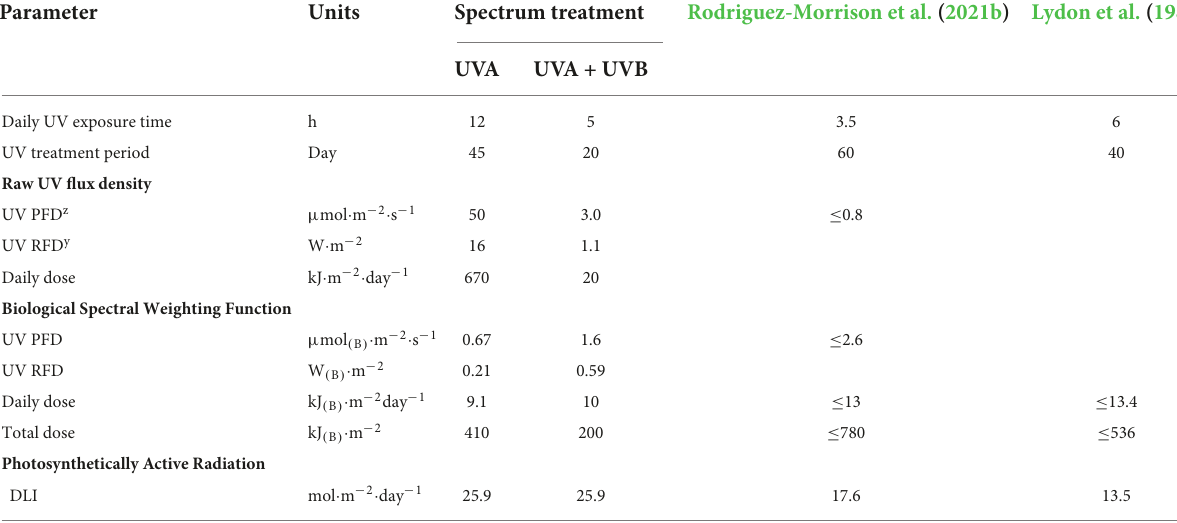
TABLE 1 Exposure periods, instantaneous and daily integrated ultraviolet (UV, 280–400 nm) flux densities at canopy level of the UVA and UVA + UVB spectrum treatments based on both raw intensities and converted using the Biological Spectral Weighting Function (BSWF; Flint and Caldwell, 2003), and daily light integrals (DLI) of photosynthetically active radiation (400–700